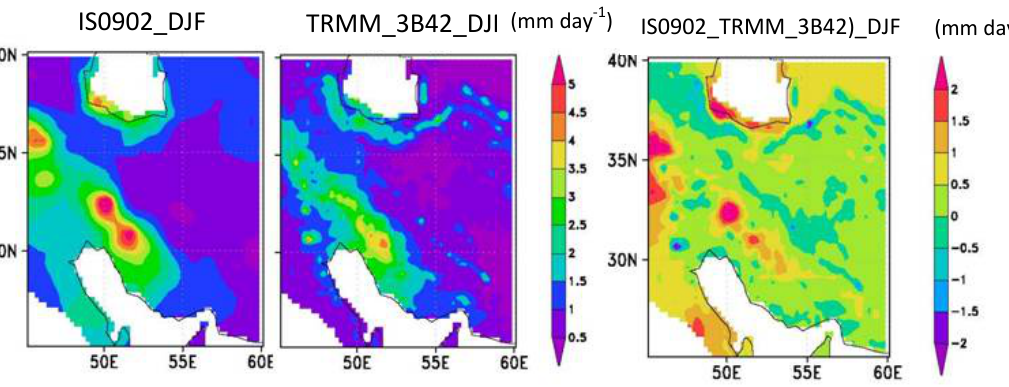
Fig. 6. Comparison of mean seasonal precipitation in IS0902 (0.25 ◦ × 0.25 ◦ ) and TRMM 3B42 (0.25 ◦ × 0.25 ◦ ) for the winter season in the time period 1998–2006. (a) IS0902 (mmday − 1 ) and (b) TRMM 3B42 (mmday − 1 ) , (c) Difference in mean seasonal precipitation between IS0902 and TRMM 3B42 (mmday − 1 ) . DJF = December, January and February.